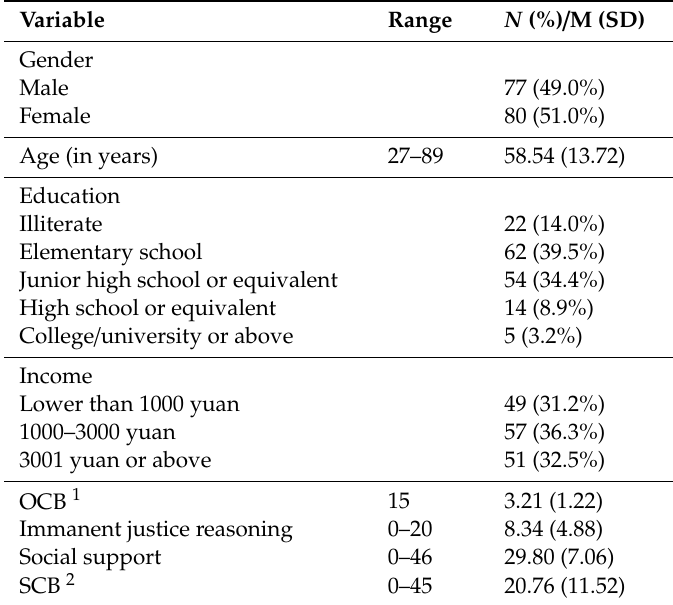
Table 1. Descriptive statistics of research variables ( N = 157).